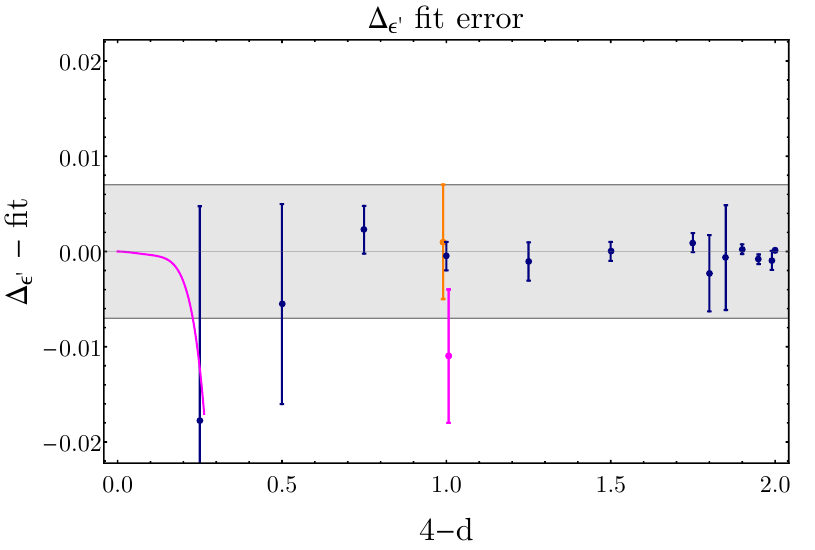
Figure 7 . Fit of (cid:1) (cid:15) 0 bootstrap data (blue) with estimated error, high-order epsilon expansion with resummed estimate at d = 3 (magenta) and Monte Carlo (orange) (references as in (cid:12)gure